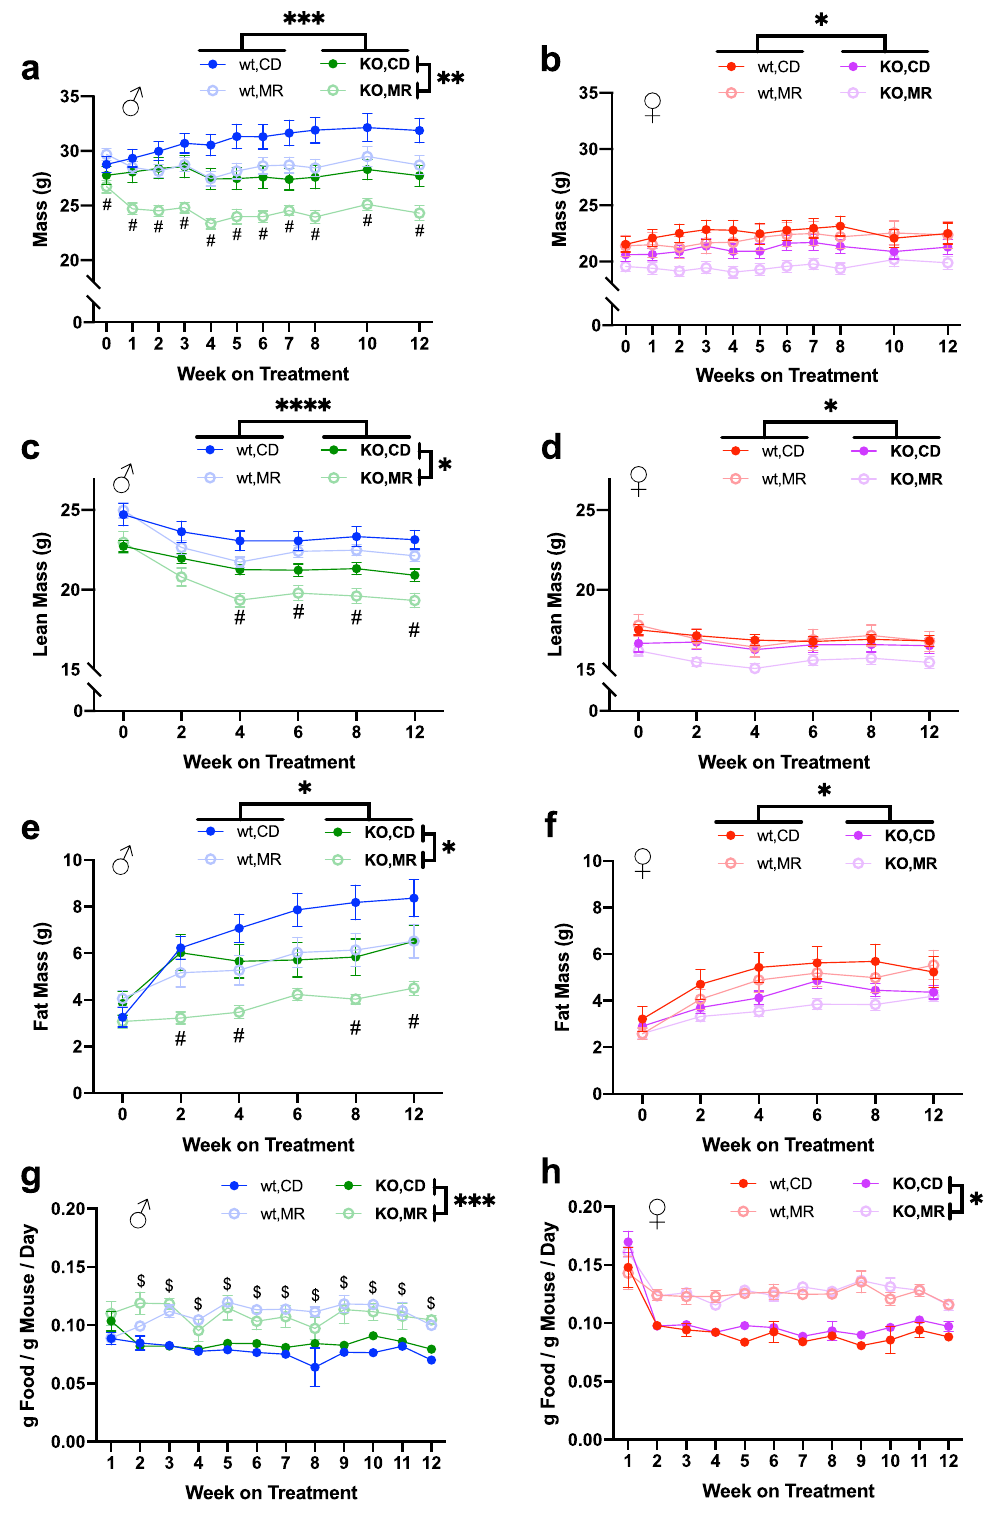
Figure 1. MR has sex-specific effects on physiological measures. Body weight ( a ), ( b ) and normalized food consumption ( g ), ( h ) measured weekly while on MR diet. Body composition data for fat mass ( c ), ( d ), lean mass ( e ), ( f ) measured every two weeks. Sexes analyzed separately with Repeated Measures, 3-Way ANOVA. Main effects for diet and MsrA KO genotype indicated by significance bars by legends (right side and above, respectively). Post-hoc diet specific effect within a genotype was analyzed with Repeated Measures, 2-Way ANOVA Multiple Comparisons with False Discovery Rate correction, Q = 0.05. Means at specific time points being significantly different ( p < 0.05) between diets for wild type denoted by dollar sign ($) and for MsrA KO denoted by a pound sign (#). Graphs represent means ± s.e.m, and all groups were 8–10 mice. (* p < 0.05; ** p < 0.01; *** p < 0.001; **** p <